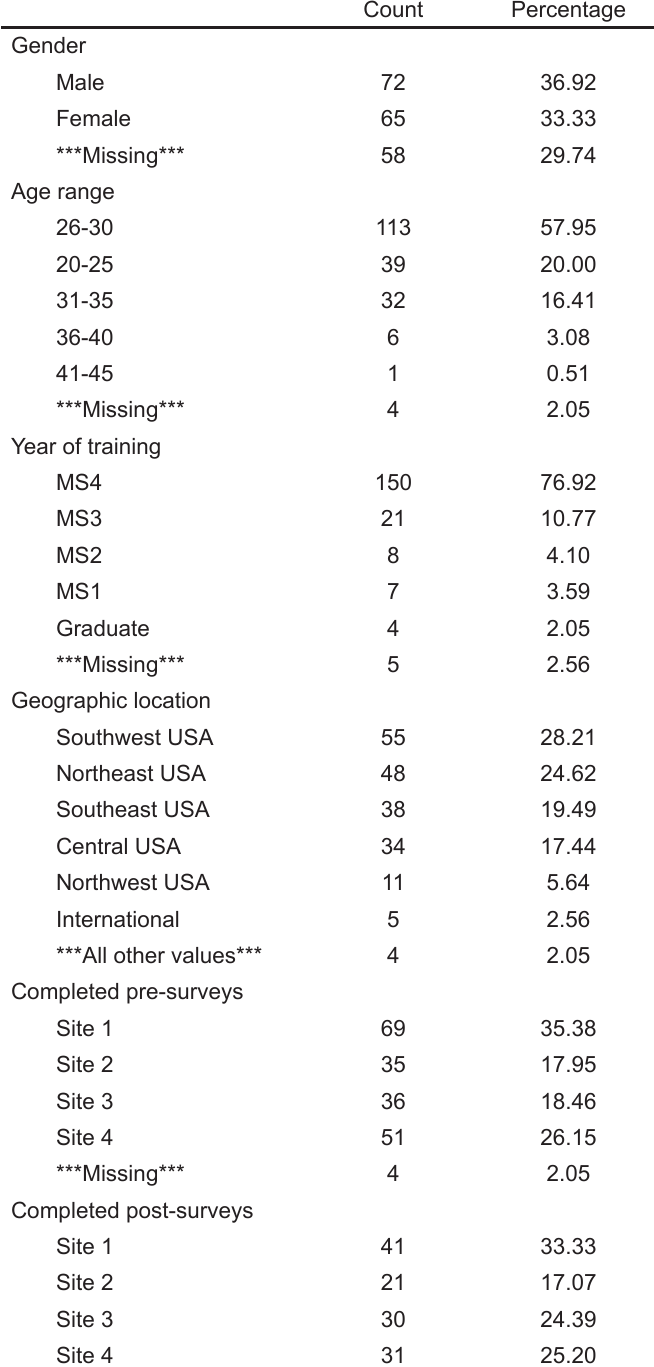
Table 2. Respondent